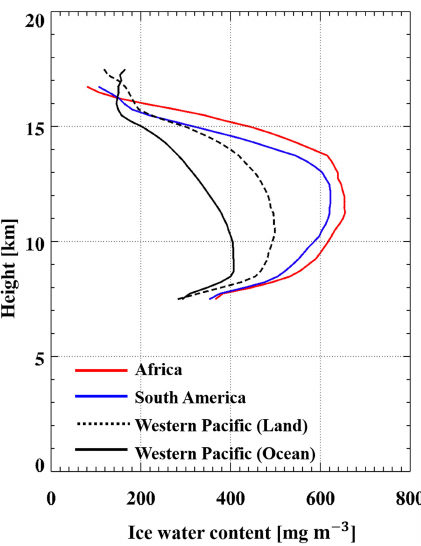
Figure 7. Same as Fig. 4 but for CloudSat-derived ice water content.